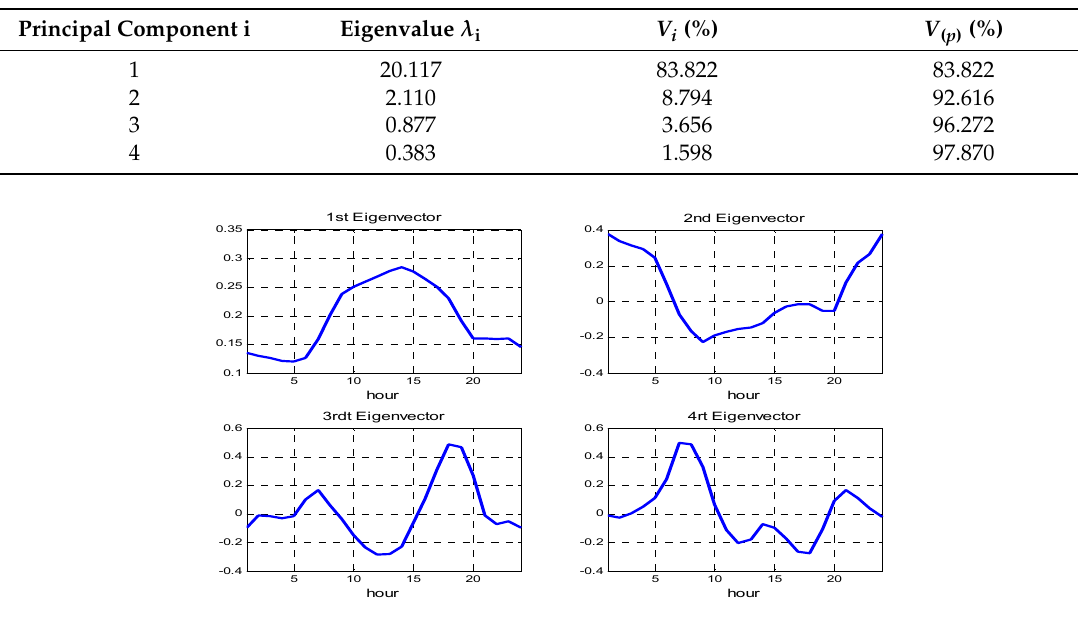
Figure 11. Principal component analysis of the load series, for the time period 2004–2014.